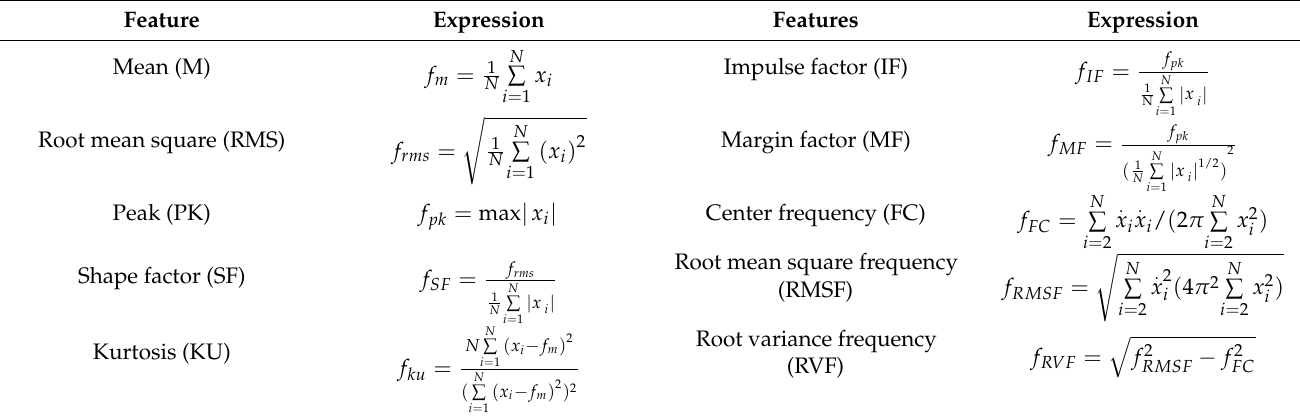
Table 1. Feature parameters and their